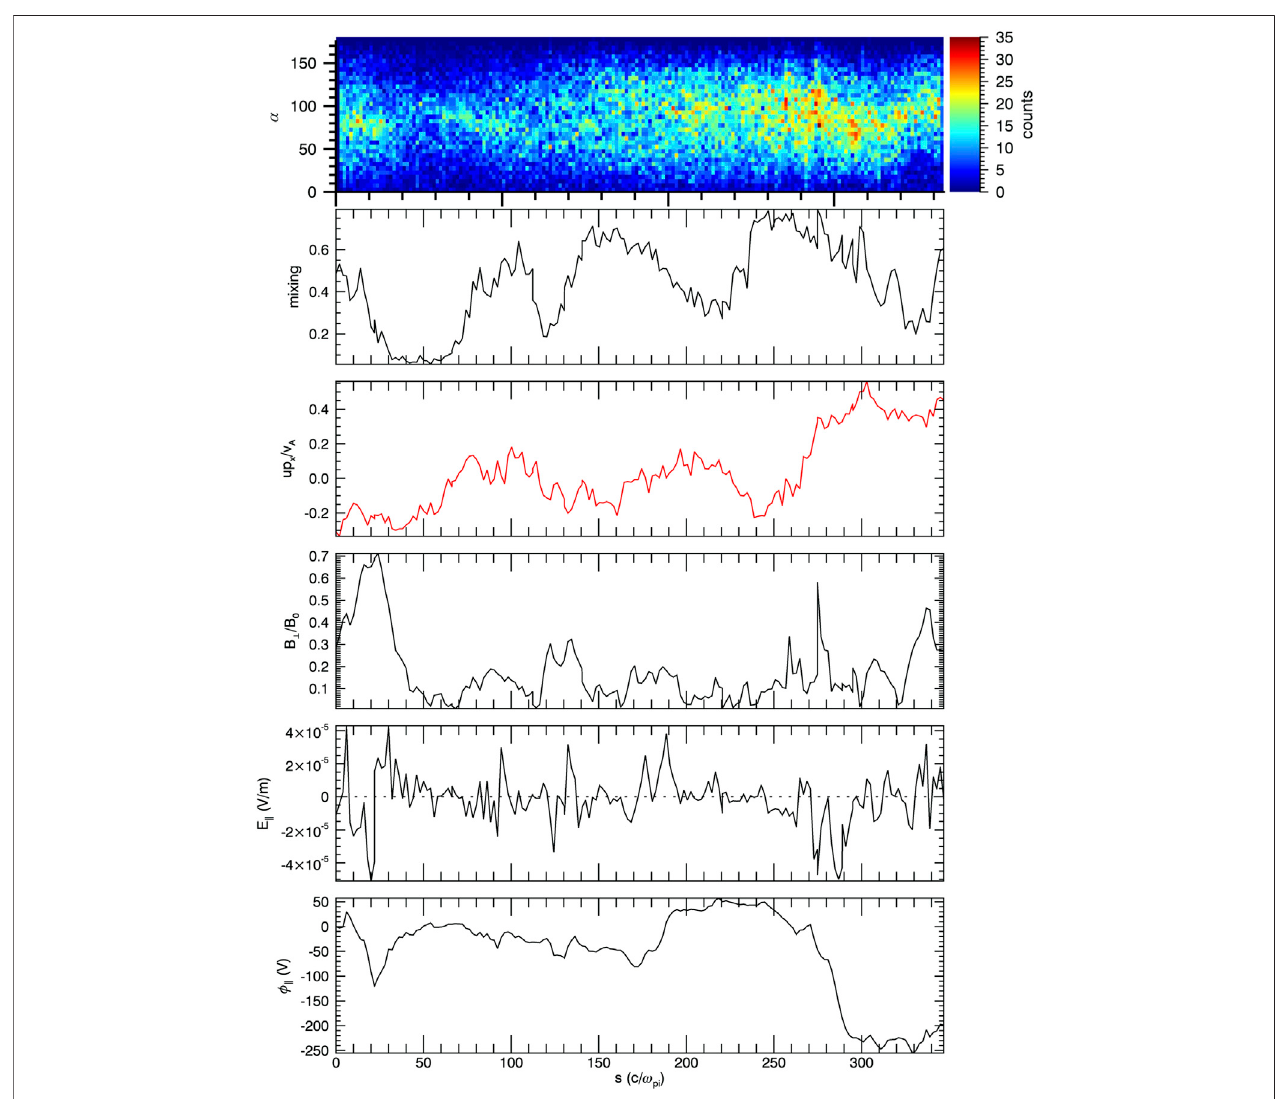
FIGURE10| Magnetic fi eldlinetracethroughKHactiveregioninhybridsimulation,showingvariousproperties.Fromtoptobottomis “ superthermal ” ions,plasma mixing, plasma fl ow, in-plane magnetic fi eld normalized to the background magnetic fi eld, parallel electric fi eld, and fi eld-aligned potential.